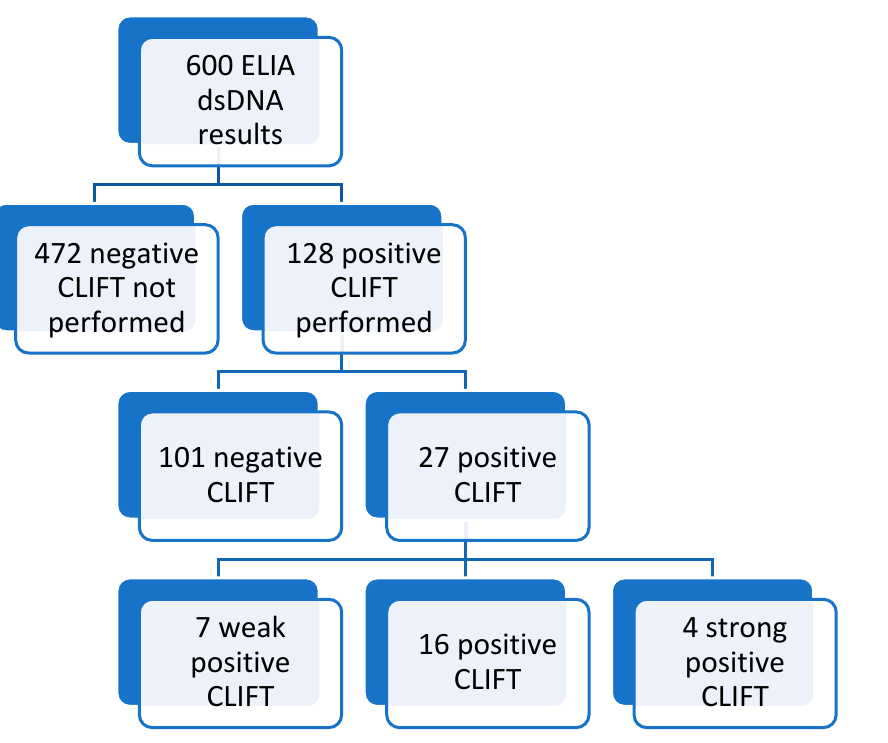
Figure 6. Summary of results from audit of 600 sample requests for anti-dsDNA antibody testing.